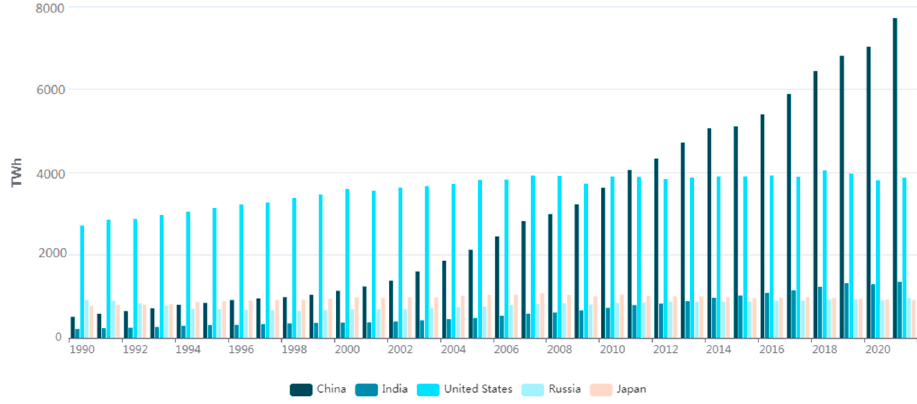
Figure 2. Dynamic pattern of electricity consumption in 2000–2021 in the five countries with the highest electricity demand.